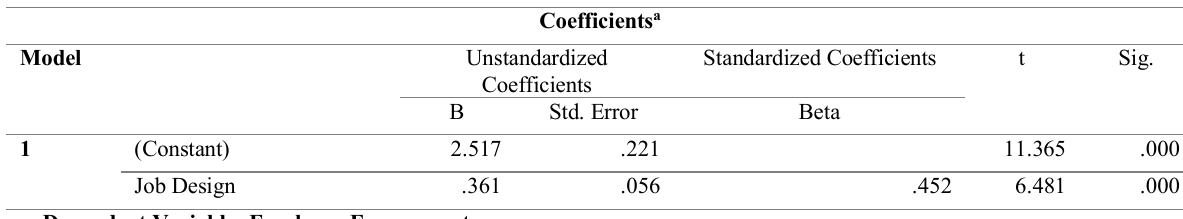
Table 3 (c): Regression Coefficients for Job Design and Employee Engagement